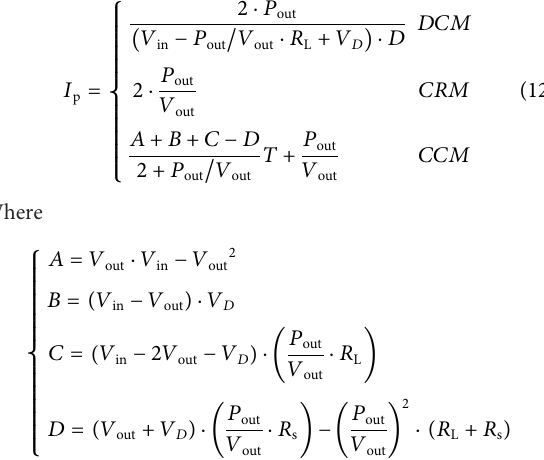
FIGURE 8 Buck converter topology of parasitic parameters.